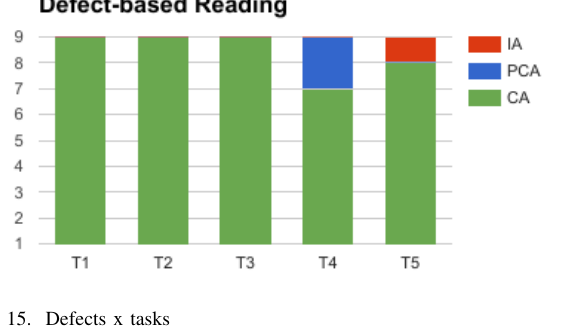
Fig. 15. Defects x